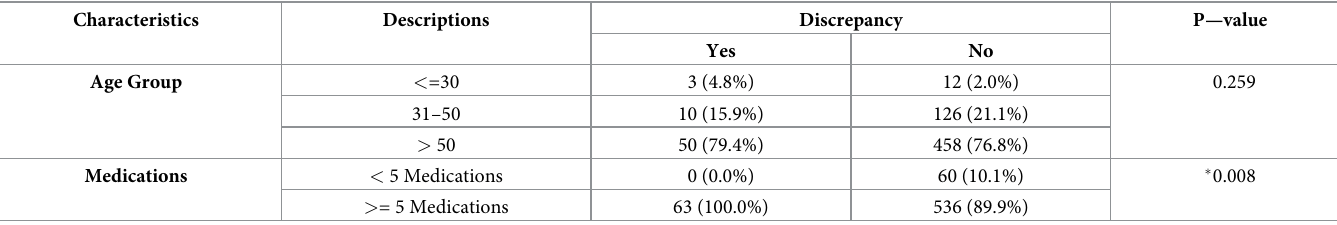
Table 3. Association between the unintentional discrepancy of the medication and study characteristics.